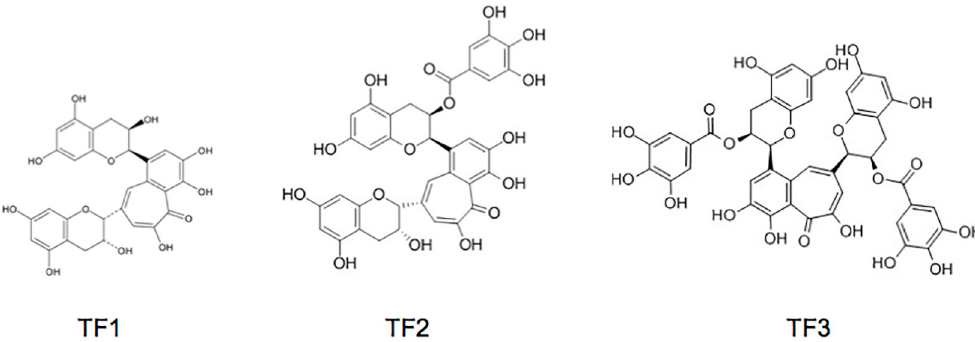
Fig 1. Chemical structures of theaflavins extracted from black